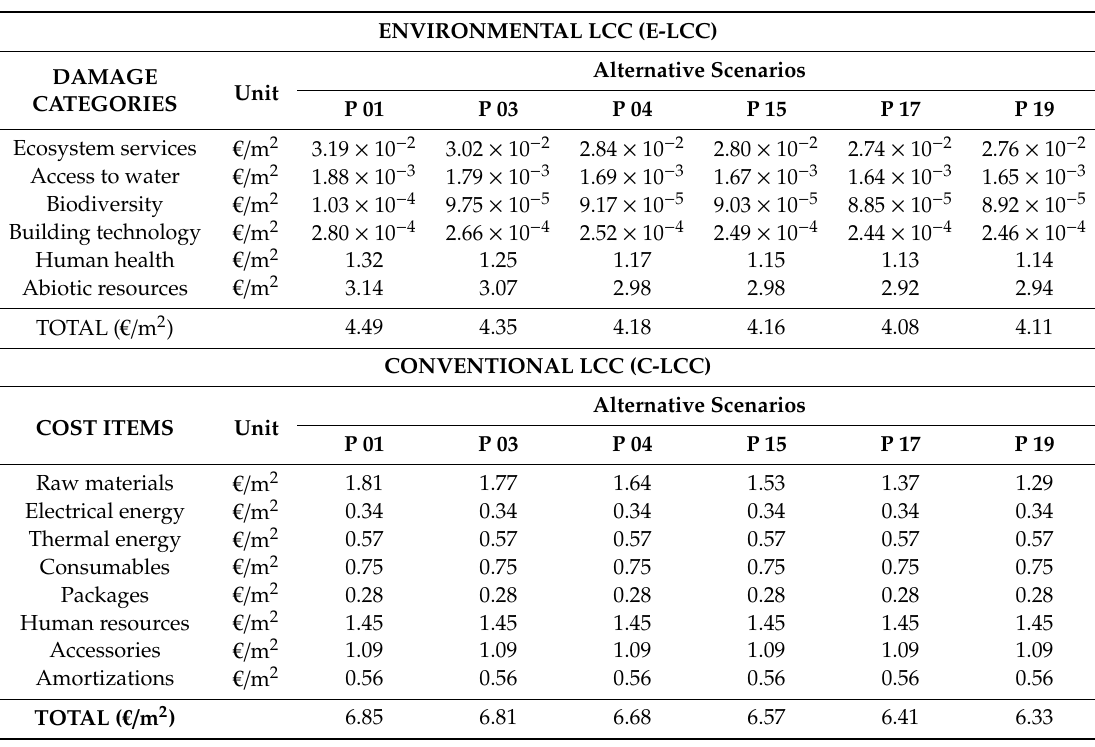
Table 3. Life Cycle Costing (LCC) for 1 m 2 of ceramic tile.